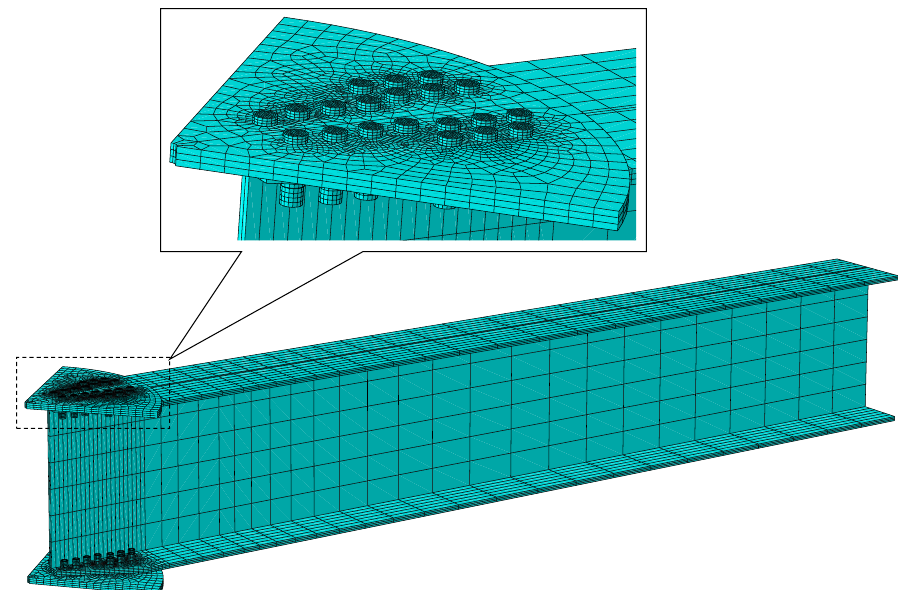
Figure 7. A meshed model of the AAG joint.